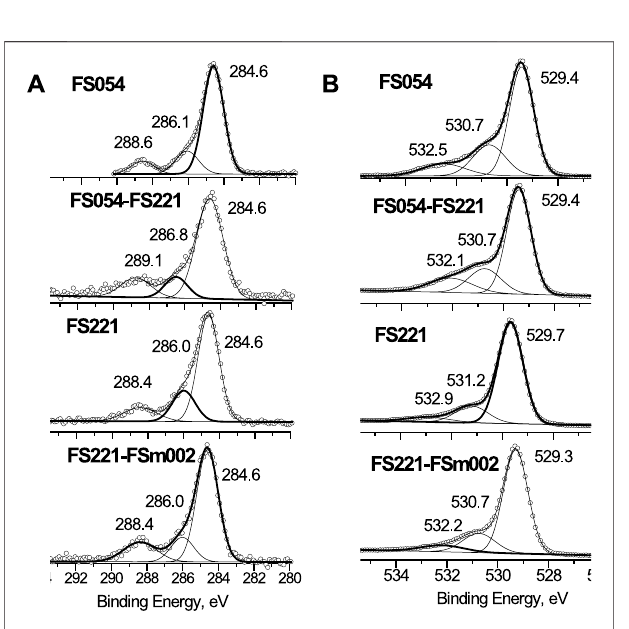
FIGURE 4 | C1s (A) and O1s (B) XPS spectra of catalysts before CFP.